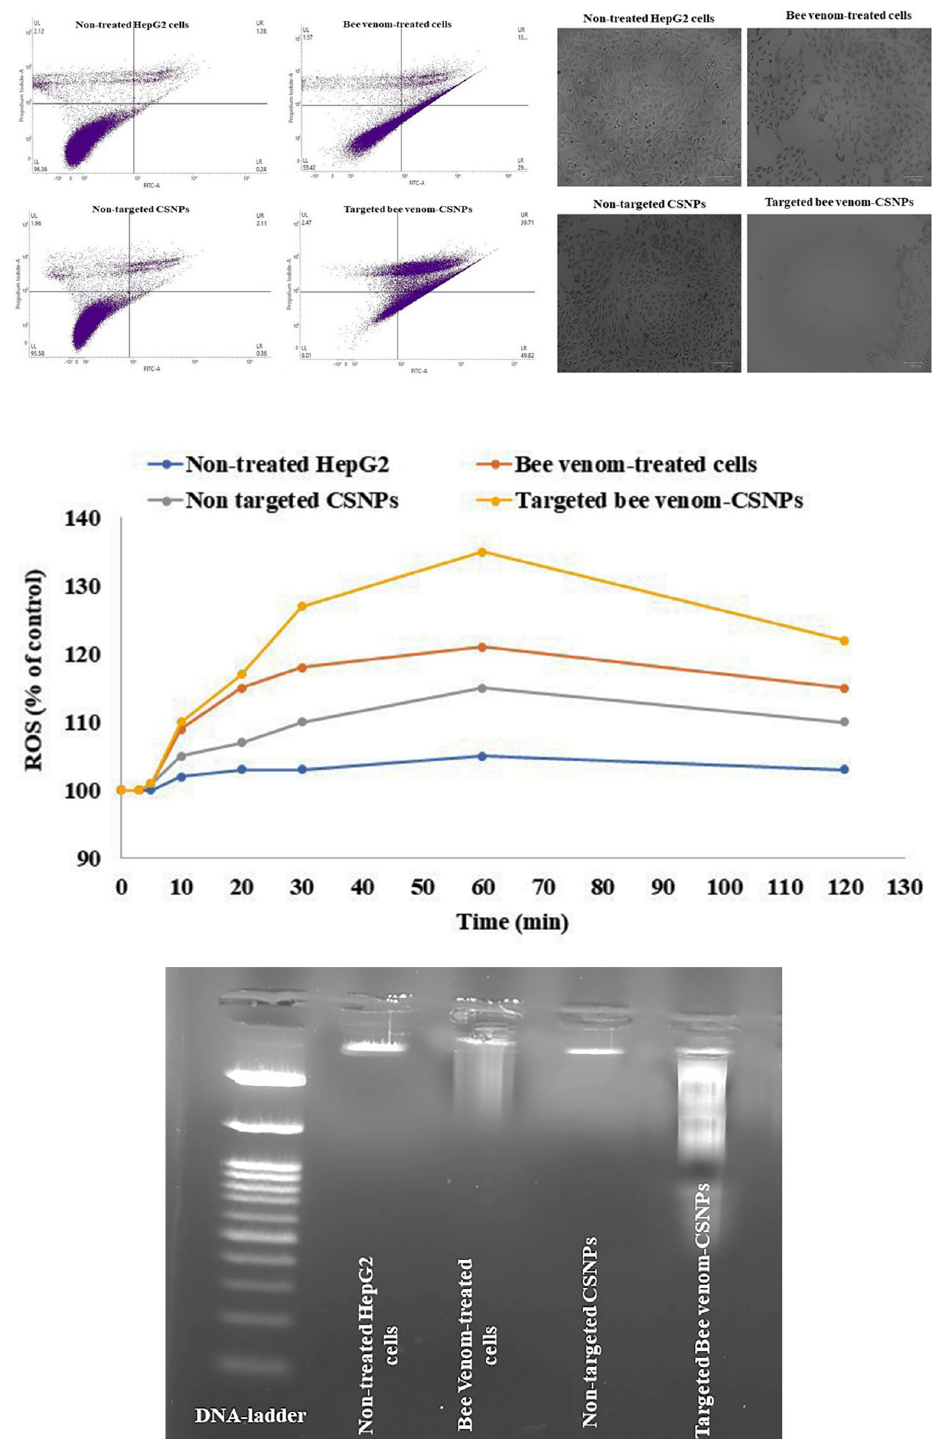
Fig 8. Studying the effects of targeted bee venom-CSNPs, non-targeted CSNPs, or native bee venom on induction of cell apoptosis. ( A ) Flow cytometry analysis; ( B ) ROS; and ( C ) DNA fragmentation in HepG2 treated cells.